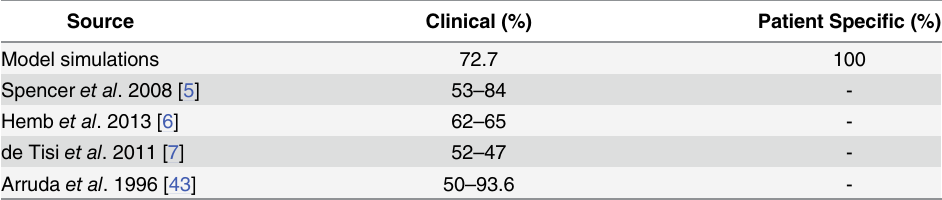
Table 1. Percentage of subjects with significant improvements following surgery. A comparison of the model generated success rate with reports in literature. In studies there have not been any patient specific procedures reported to compare, so these reports only include widely used clinical procedures including the amygdalohippocampectomy. The wide ranges in some reports are due to studies grouping patients by differ- ent criteria such as lateralisation of atrophy, or in other cases due to longitudinal studies measuring improve- ments at several different time points after the surgery. There is a general trend of decreased improvement the longer the time period after surgery, reducing the reported